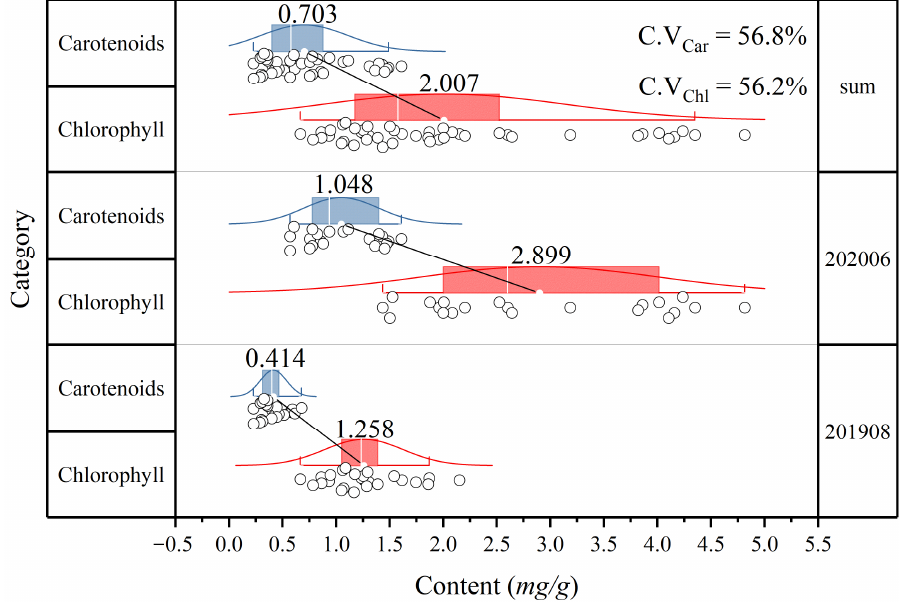
Figure 4. Descriptive statistical chart of measured chlorophyll and carotenoid contents in the PeITCs.